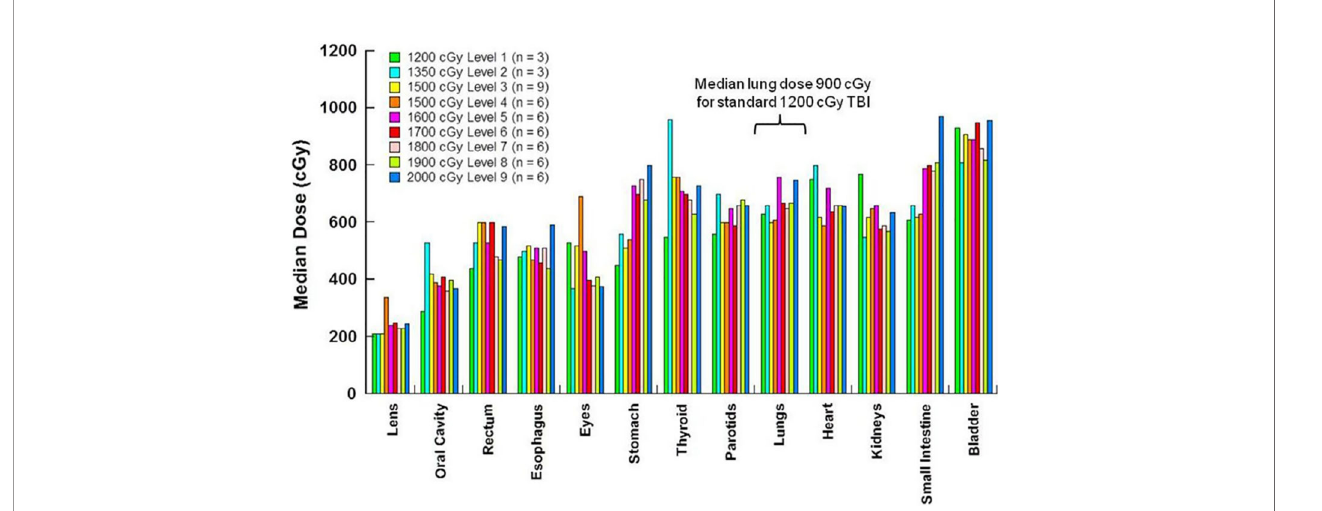
FIGURE 6 | TMLI median organ dose by phase 1 dose levels the dose levels and number of patients at each dose levels are indicated the doses plotted are average for the patient at each dose level.